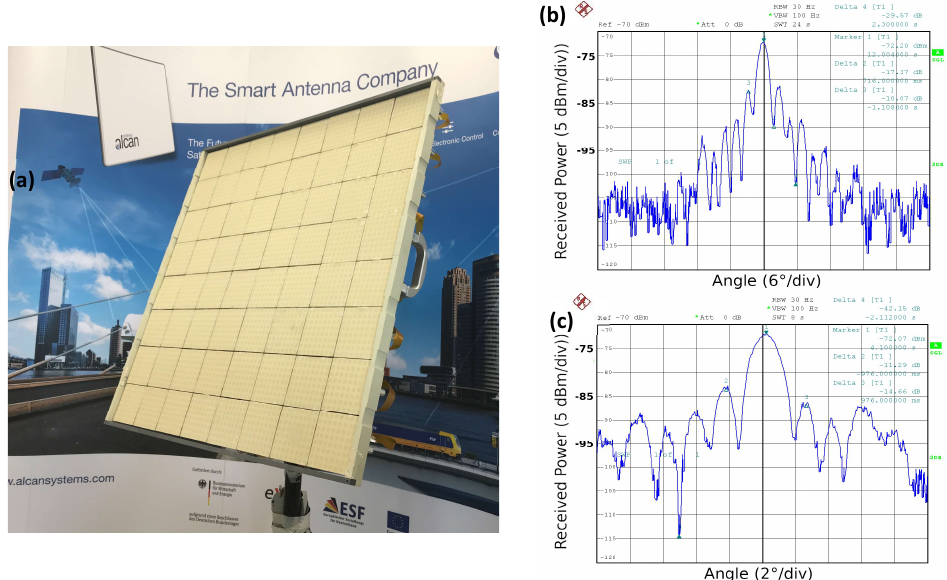
Figure 35. ( a ) Ku-band TV reception demonstrator with ALCAN’s first-generation antenna to steer the beam between different GEO satellites, using a 100 µm LCD process for the phase shifter stack. ( b ) Horizontal and ( c ) vertical antenna pattern for a beam in the boresight direction (note the different angular scales) [253]. Courtesy of ALCAN Systems GmbH.